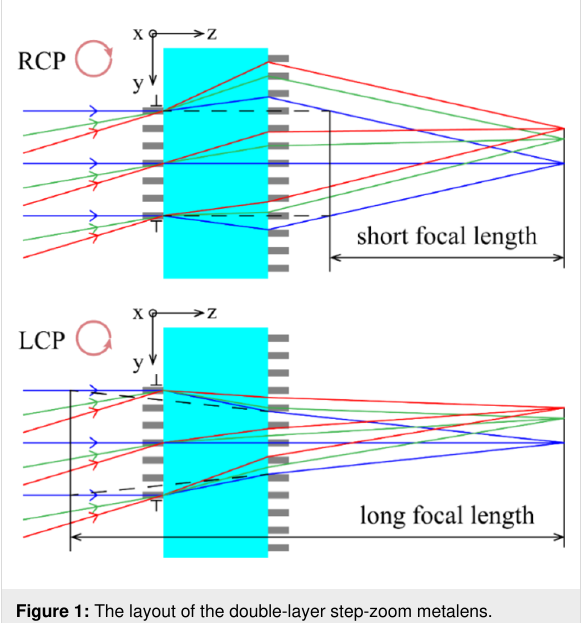
Figure 1: The layout of the double-layer step-zoom